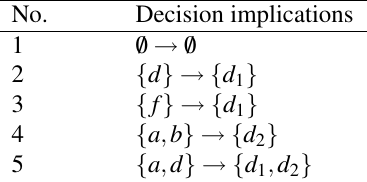
Table 4. A Π # -base of